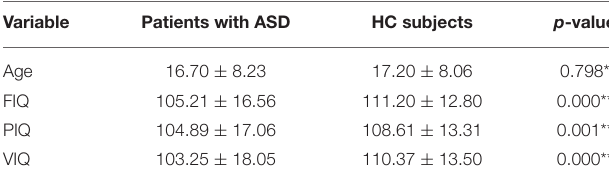
TABLE 1 | Basic information of the